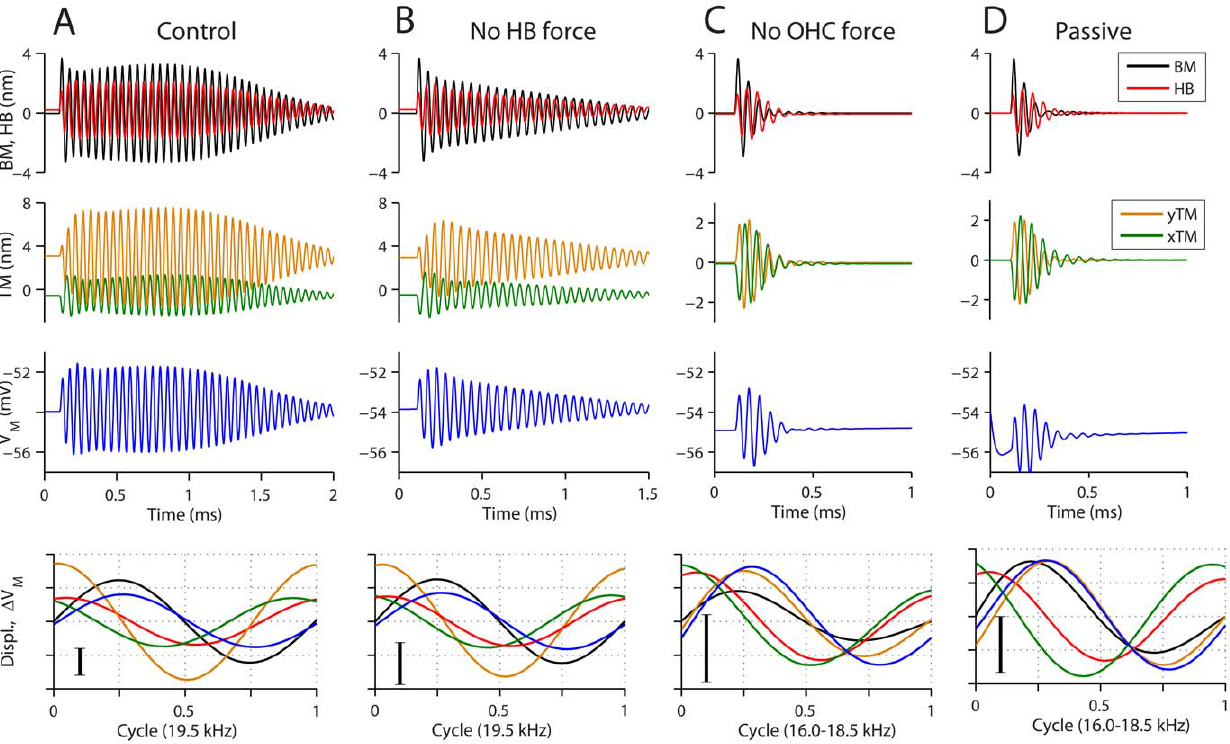
Figure 2. Impulse response of the cochlear partition. An impulse of 0.5 nN-ms was applied to the middle of the BM at t=0.1 ms. Four cases are: ( A ) Control with both hair-bundle mechanotransduction force and somatic force; ( B ) hair bundle mechano-transduction force set to zero; ( C ) OHC somatic force set to zero; and ( D ) without active mechanical feedback from the OHCs. Top row: BM displacement, hair bundle shear displacement. Second row: TM displacements in the x- and y-direction (radial and transverse direction). Third row: OHC membrane voltage. Bottom row: the responses for one cycle were plotted together after subtracting the DC component. The vertical scale bars indicate 1 nm and 1 mV.